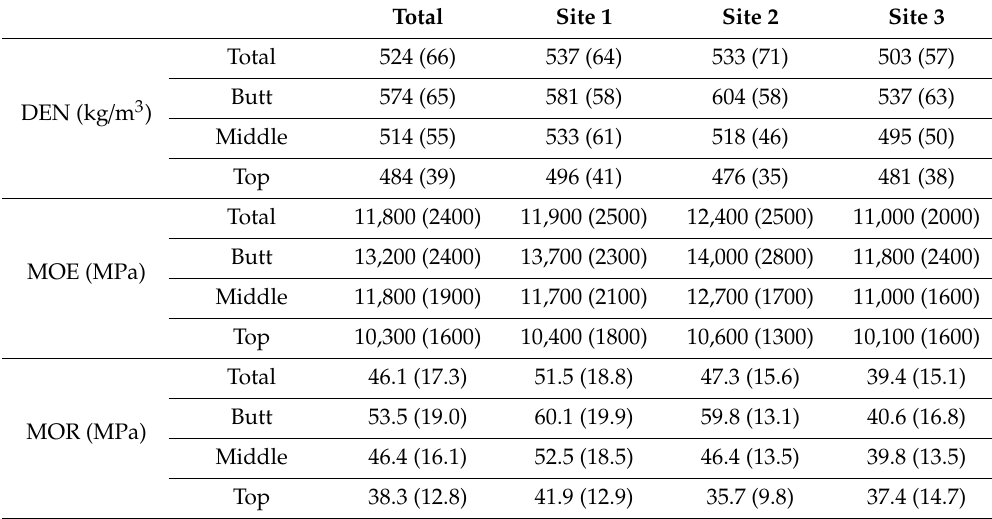
Table 2. Average values of density, modulus of elasticity and bending strength for the Scots pine timber under research (standard deviation is given in parentheses), DEN—density, MOE—modulus of elasticity, MOR—bending strength.